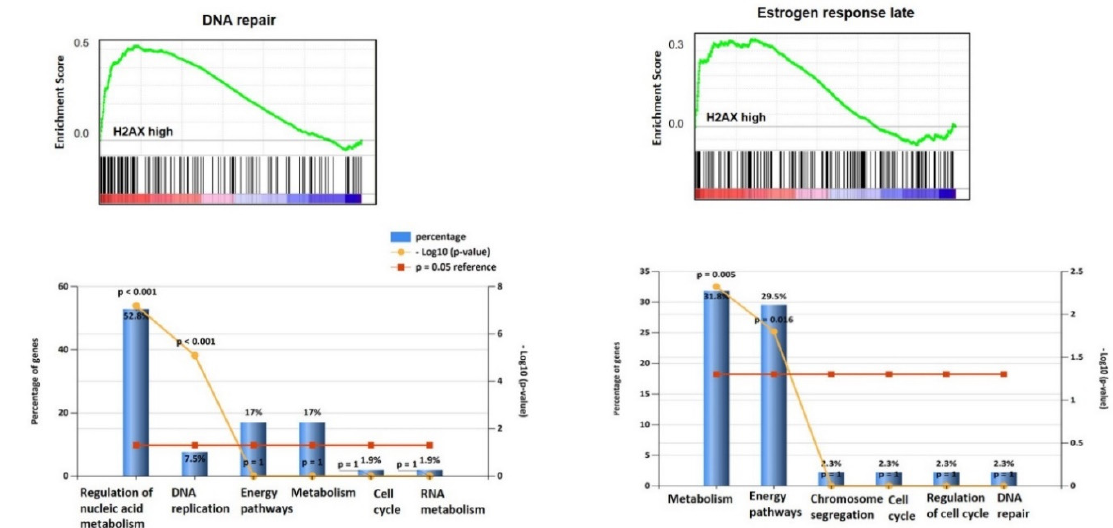
Figure 3. Gene enrichment on genes significantly associated with DNA repair and Estrogen response (late), with significant biological processes of regulation of nucleic acid metabolism and DNA replication for the DNA repair group, and metabolism and energy pathways for the Estrogen response cohort.